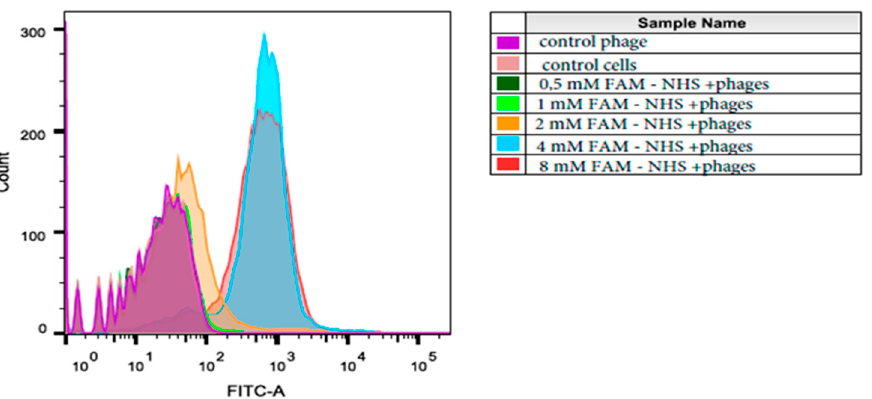
Figure 5. The flow cytometry of the tumor cell MDA-MB 231, which was incubated with M13-FAM phages. Notes: purple—control phage cells incubated with unmodified phages; pink—control cells without phages; dark green—cells incubated with phages modified by 0.5 mM FAM-NHS; light green—by 1 mM FAM-NHS; orange—by 2 mM FAM-NHS; blue—by 4 mM FAM-NHS; red—by 8 mM